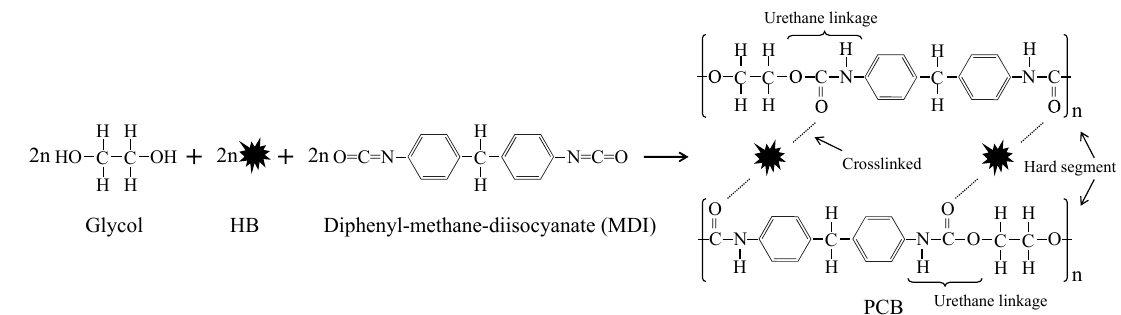
6 of 19 filled the columns, denoted as PCB-Column, HB-Column and Sand-Column. Sand-Col- umn was filled only with river sand as a control group. For each 2 cm of mixed filling, a wooden hammer was employed to drop 10 times from 5 cm above the filling until it was filled to 24 cm. Washed and dried gravels were placed on top of the mixture filling to prevent current scour. After filling, peristaltic pumps (BT01-100) were used at the top of the columns to pump DW for 3 hours at a speed of 15 mL/min. The inflow velocity was calculated according to the rainfall intensity formula in China. In this study, rainfall oc- curred once a year and lasted for 3 hours, the catchment ratio was 15 and the infiltration flow per minute was calculated as 15 mL. In total, 50 mL of effluent was collected every 20 minutes by the effluent tubing at the bottom in order to detect the contents of PO 4 -P. The detection methods were the same as above. AS was pumped at the same rate for 3 hours after the DW was pumped in for 3 hours. AS included 3 mg/L PO 4 -P. Effluent was collected and measured as above. 3. Results and discussion 3.1. Polymerization Process and Microstructure